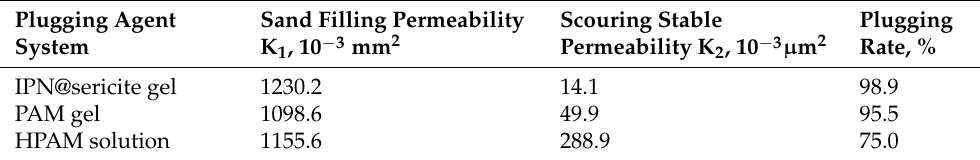
Table 5. Experimental results of erosion resistance of water expansion.